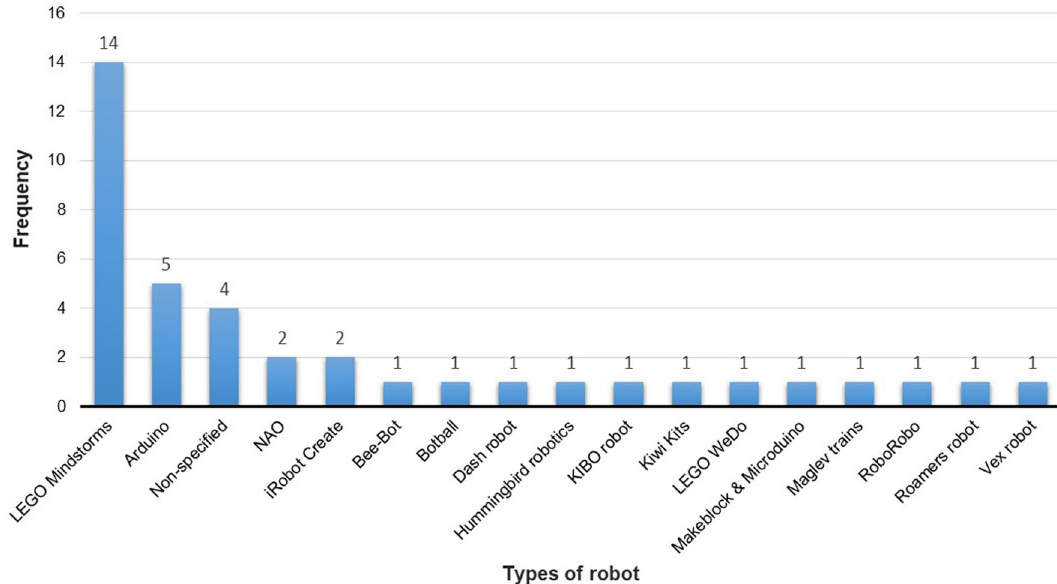
Fig. 10 Frequency of types of robots used